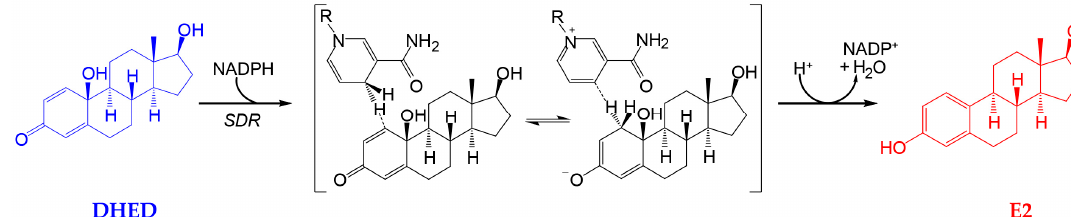
Figure 1. 10 β ,17 β -dihydroxyestra-1,4-dien-3-one (DHED) is a bioprecursor prodrug converted to 17 β -estradiol (E2) in neuronal environments through NADPH-dependent enzymatic reduction [22,23]. SDR, short chain dehydrogenase / reductase; only the 1,4-dihydronicotinamide and the corresponding pyridinium moieties are displayed for NADPH and nicotinamide adenine dinucleotide phosphate (NADP + ), respectively, with the rest of the structure not participating in the reaction indicated by R.